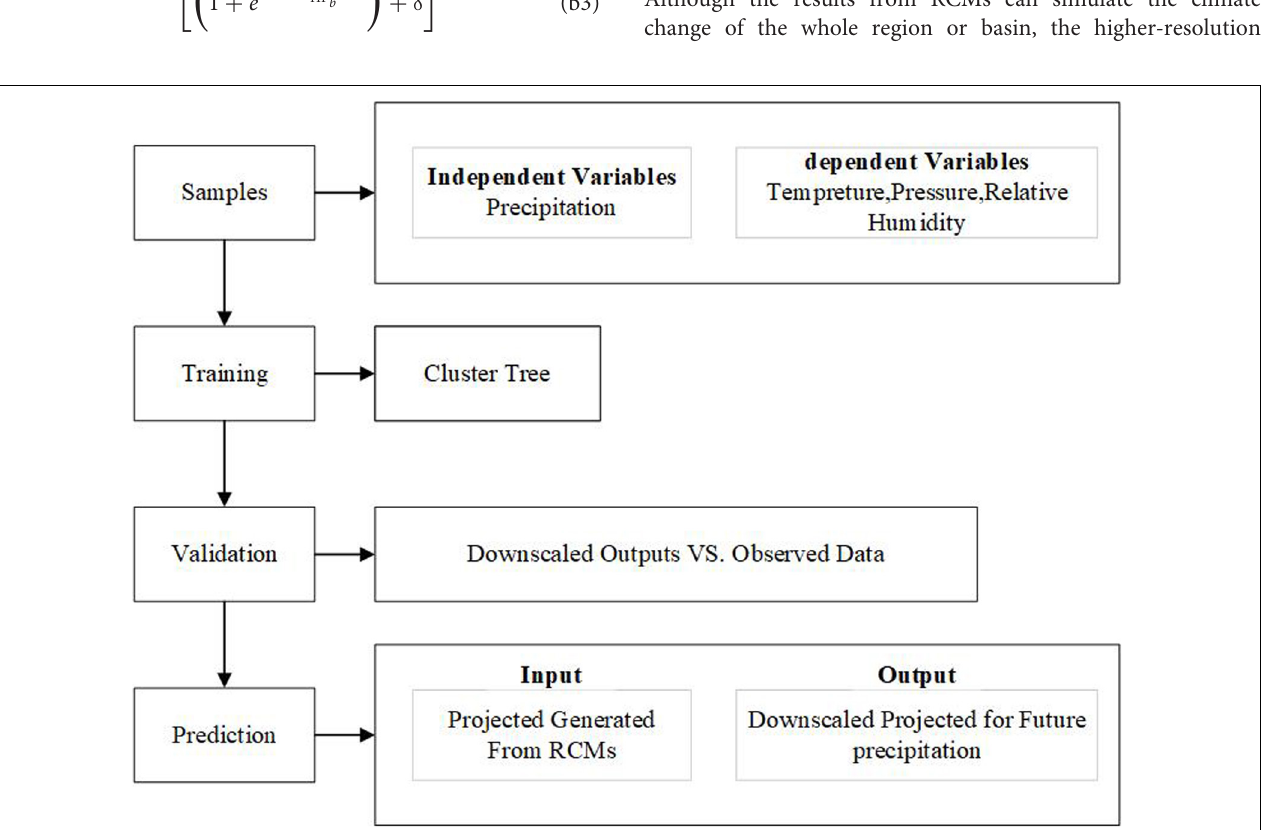
FIGURE 3 | Stepwise cluster analysis downscaling flow